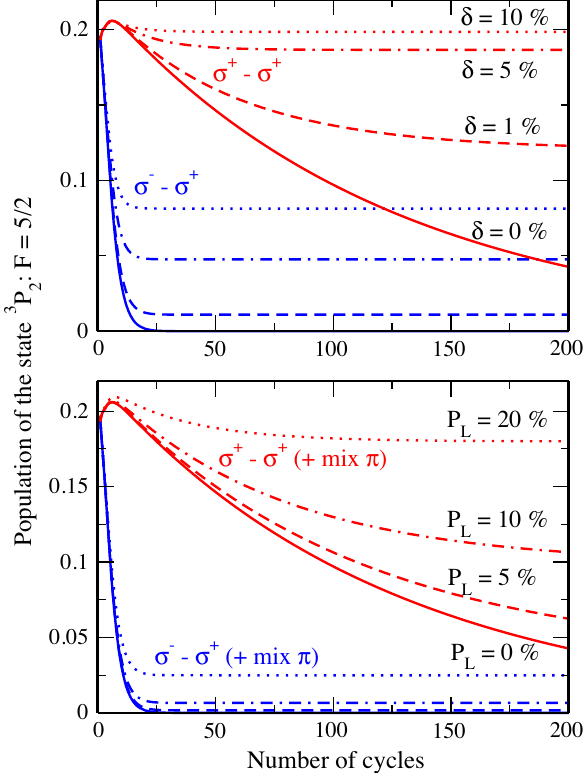
FIG. 8. The same as Fig. 7, but for the cases where the population of hyperfine substates is partially distorted by the magnets in the storage ring and collisions (upper panel), and the σ polarization of the red laser has an admixture of the π linearly polarization component (lower panel). In order to estimate the effect of the depolarization in the magnets and collisions, a particular fraction δ of the population of each substate j FM F i was evenly redistributed among ground-level substates after each round trip. The imperfection of the circular polarization is quantified by the Stokes parameter P L , or degree of linear polarization, of the π